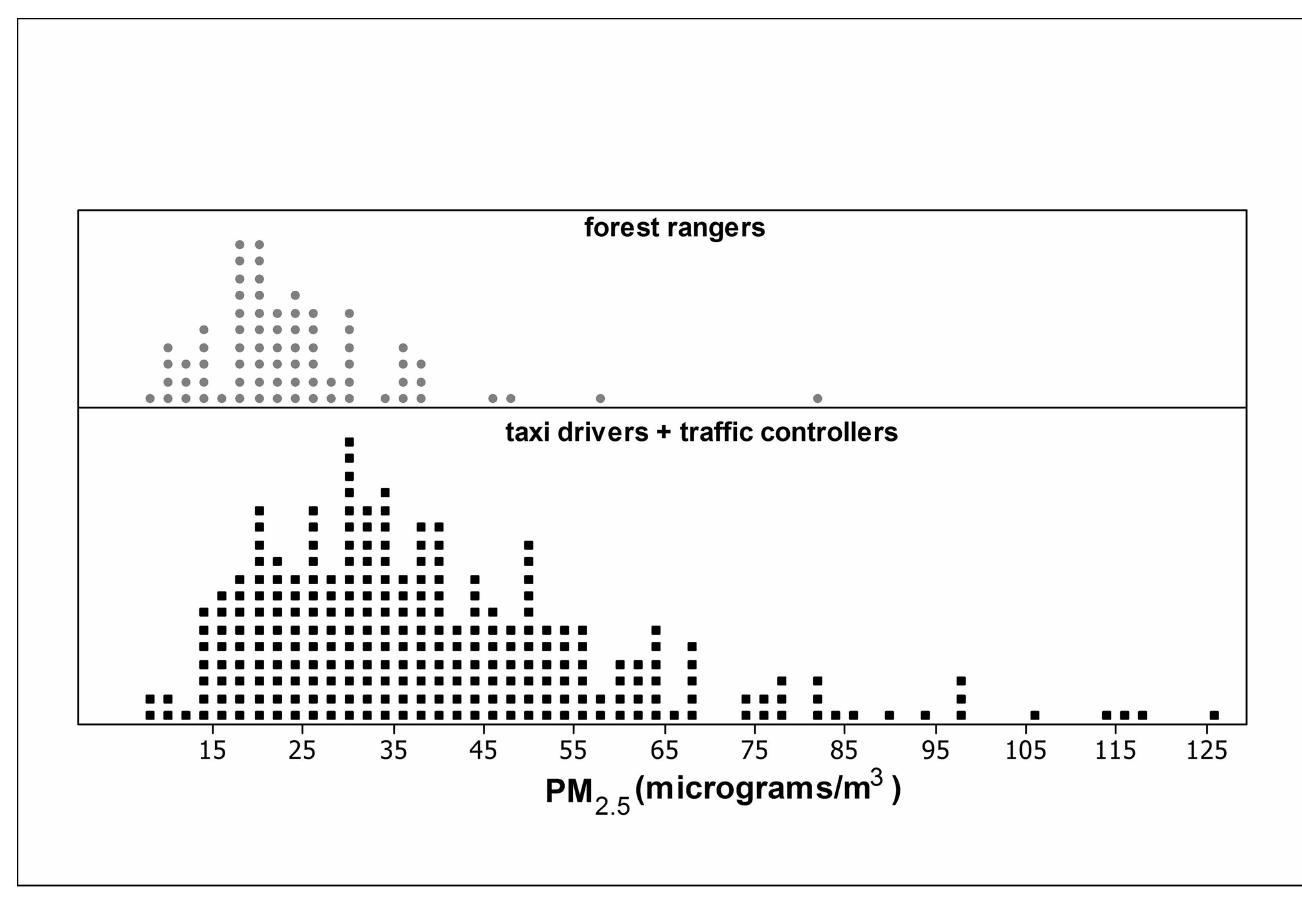
Fig 1. Dot plots of the PM 2.5 measurements of different occupation groups during the study